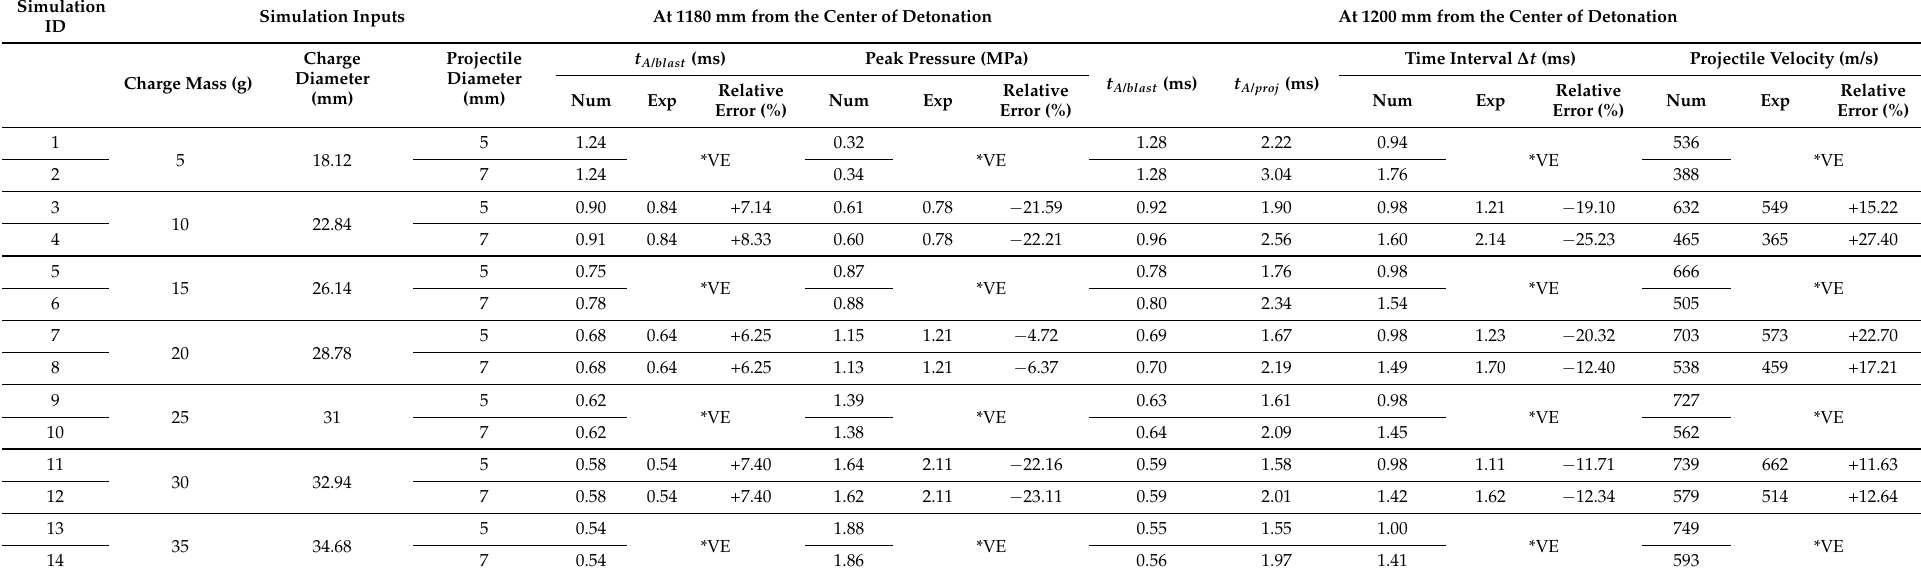
Table 5. Table of values of the numerical simulations results for the pressures, time intervals, and projectile velocities and comparison with the blast and fragment impact